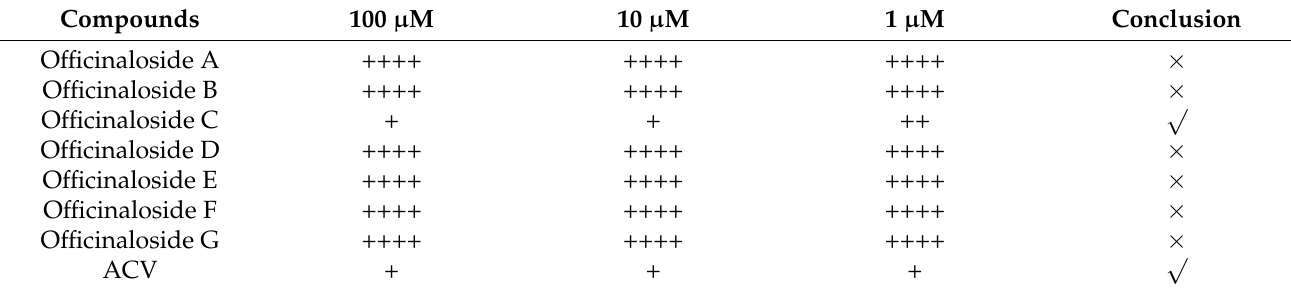
Table 1. Antiviral activity of iridoid compounds.